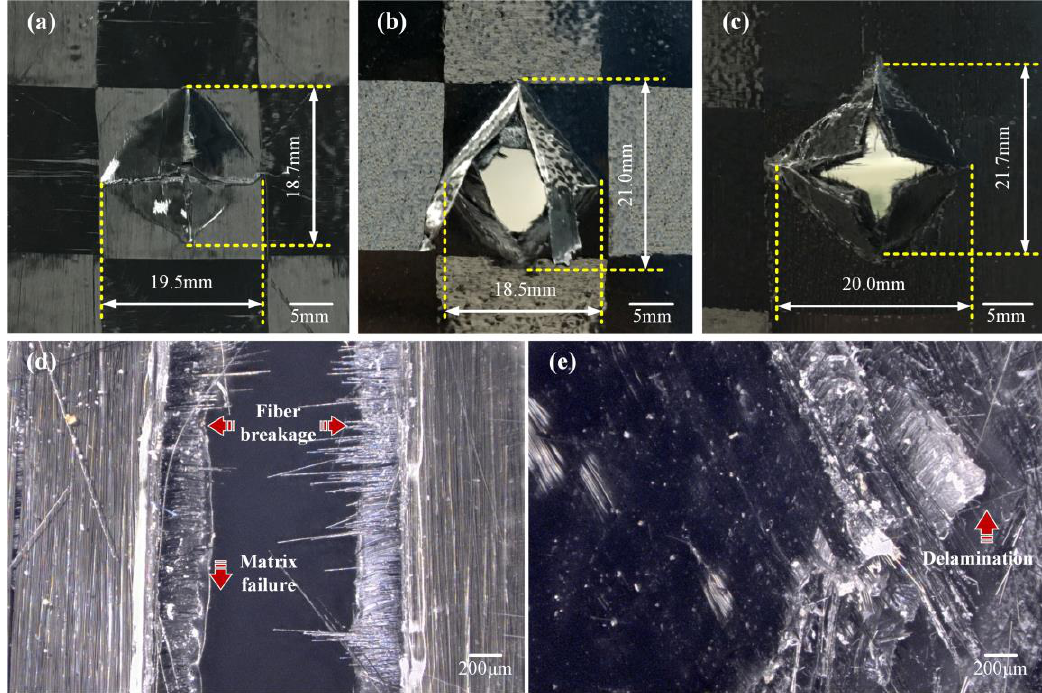
Figure 8. Impact fracture images of a multi-CFPL with different layer numbers of unit-CFPLs: ( a ) Unit-CFPL; ( b ) 3 layers; ( c ) 5 layers; ( d , e ) are the enlarged images of the unit-CFPL and 5-layer laminates, respectively.